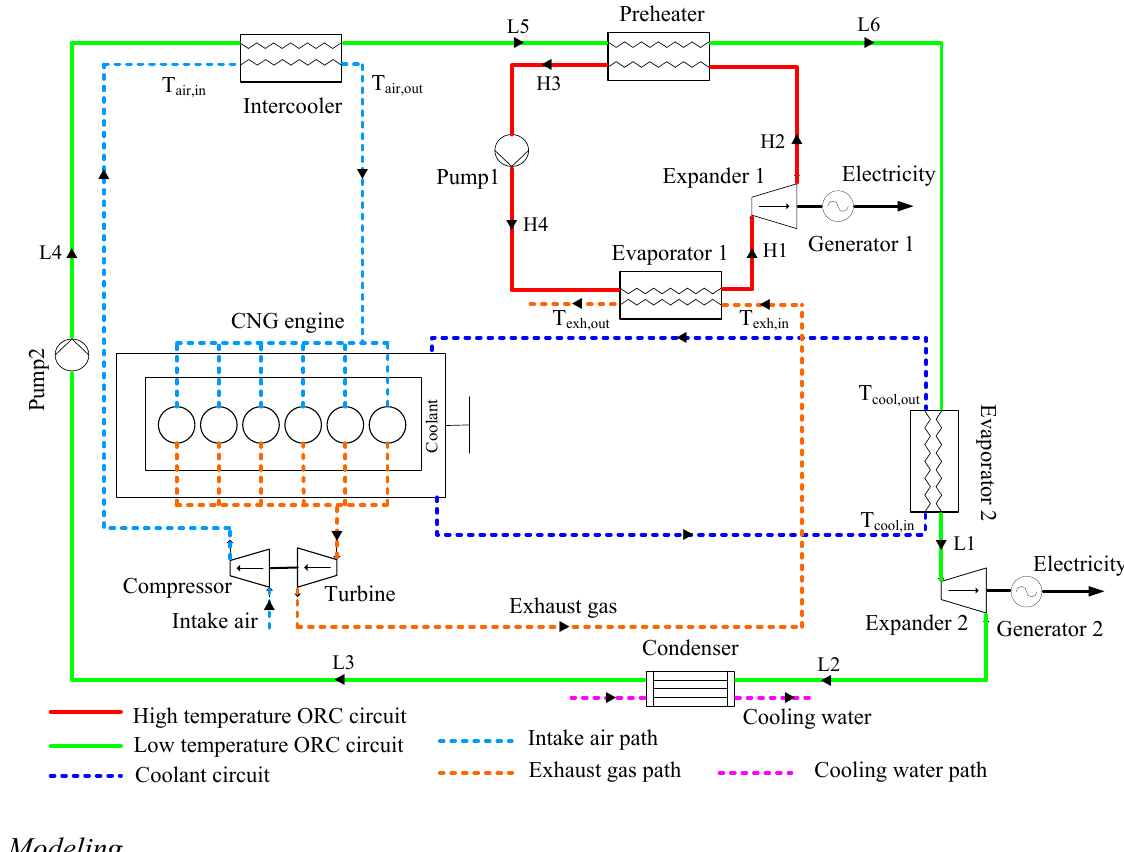
Figure 1. The schematic of the dual loop organic Rankine cycle (DORC)